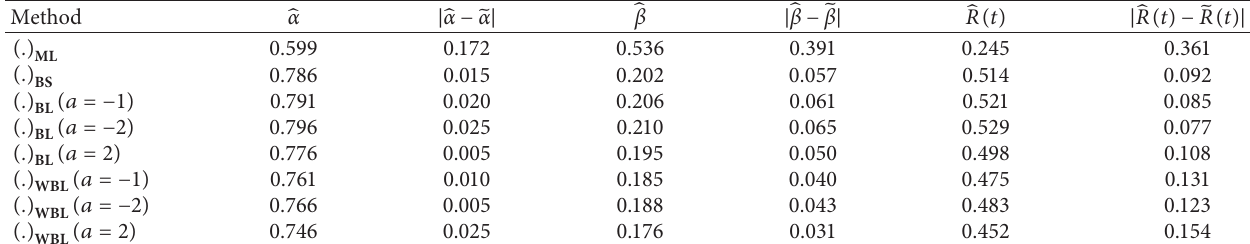
Table 2: Estimates of α , β , and R ( t ) when t � 5 and z �